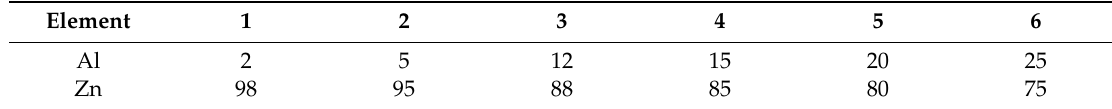
Table 1. Composition of filler metals (wt.%).